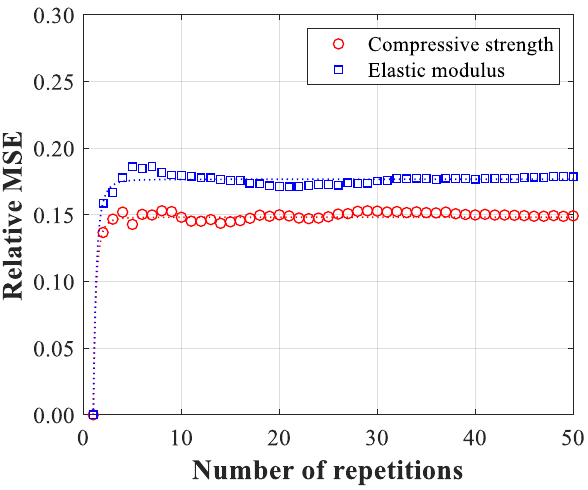
Figure 2. Relative MSE for compressive strength and elastic modulus.